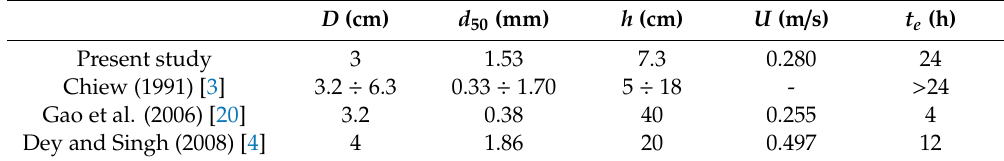
Figure 3. Comparison between centerline longitudinal scour profiles around a horizontal cylinder with e = 0. Table 2. Geometric and hydraulic parameters of the literature experimental runs for e = 0.